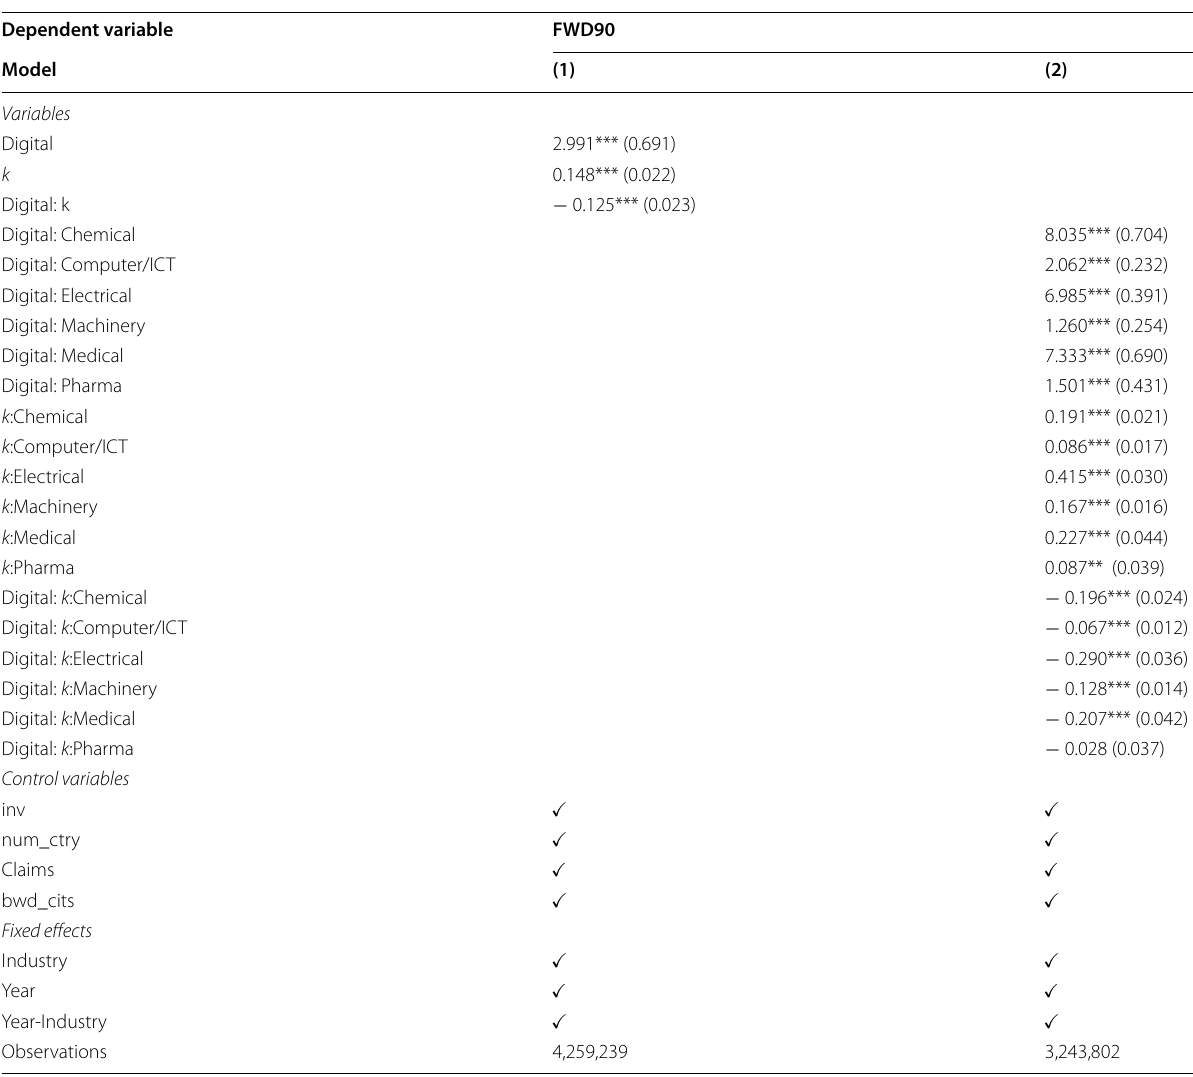
Table 15 Technological improvement rates and breakthrough innovations: heterogeneity between the digital and non-digital